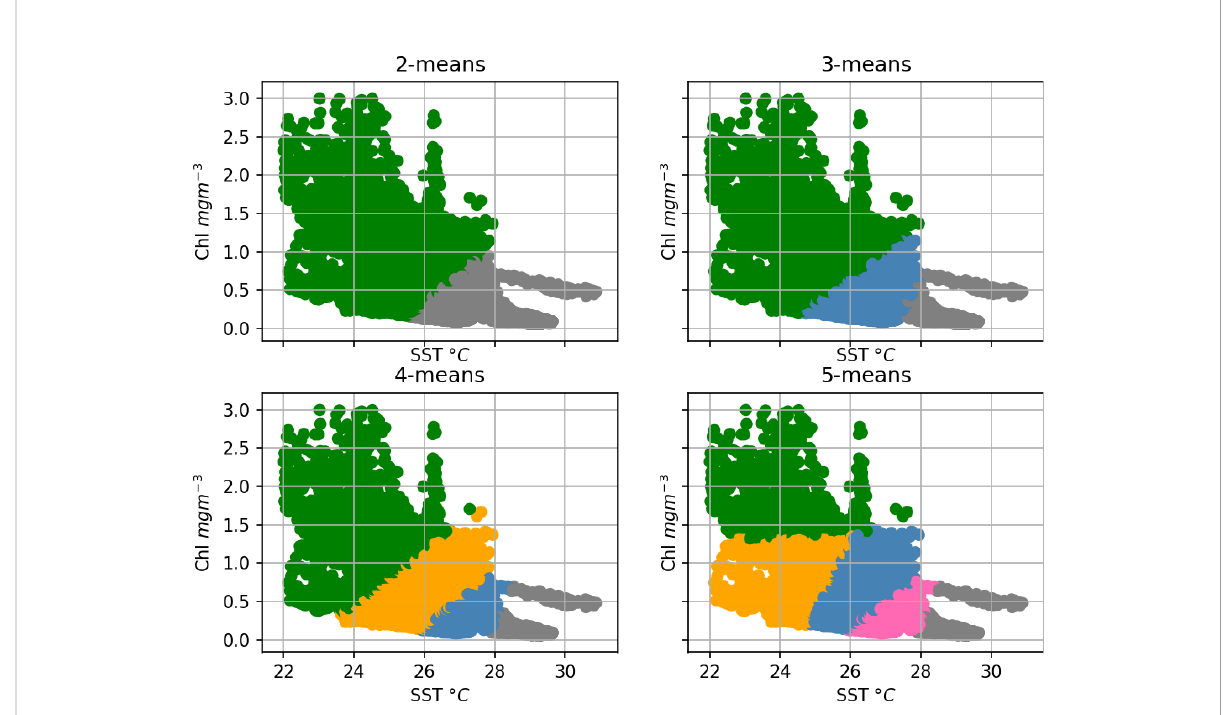
FIGURE 3 Scatter plots of SST against Chl with subplots representing different numbers of pre-de fi ned clusters, and colours indicating the different clusters for the 2-variable model